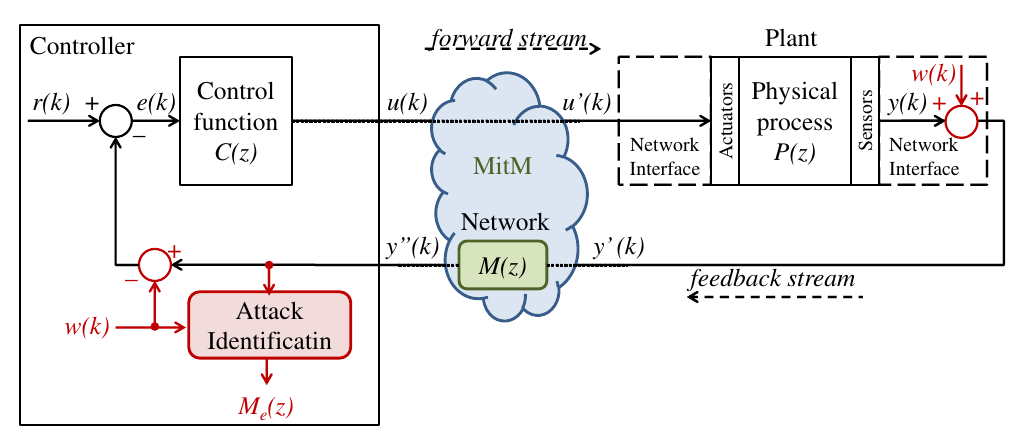
Figure 3. Identification of an SD-Controlled data injection attack